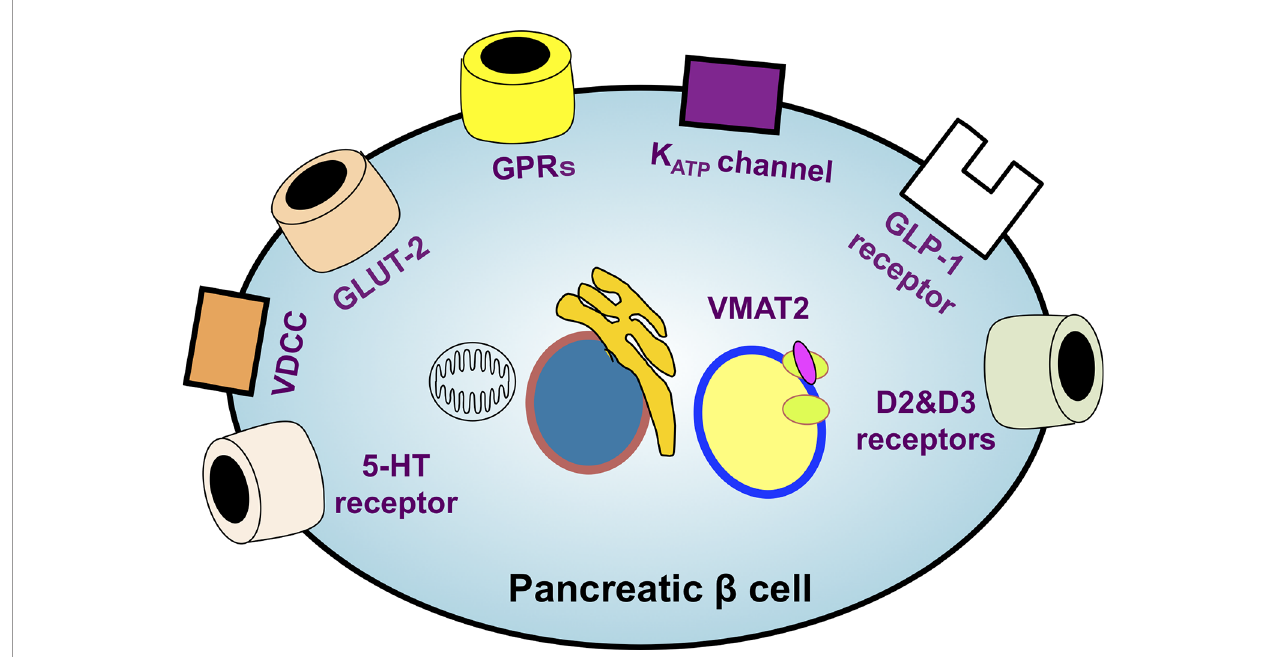
FIGURE 2 | An overview of the potential targets of b -cell-speci fi c imaging probes. The identi fi cation of ideal probe targets highly speci fi c to b cells is essential for realizing b -cell imaging. The various molecules whose expression is observed speci fi cally in b cells have been explored. SUR1, glucose transporter 2 (GLUT-2), voltage-dependent calcium channel (VDCC), G protein-coupled receptors (GPRs), D2 and D3 dopamine receptors, serotonergic system, vesicular monoamine transporter 2 (VMAT2), and GLP-1 receptors have been reported as leading potential probe targets. K ATP channel, ATP-sensitive potassium channel; 5-HT receptor, 5-hydroxytryptamine